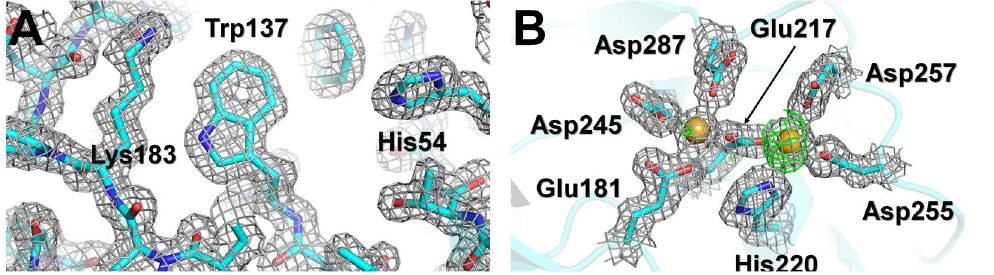
Figure 4. Electron density map of room-temperature glucose isomerase embedded in beef tallow. ( A ) 2 mFo- DFc electron density map (grey mesh, 1.2σ) of glucose isomerase. ( B ) 2mFo-DFc (grey mesh, 1.2σ) and mFo- DFc (green, 3σ; red, − 3σ) electron density map of metal binding sites at the active site of glucose